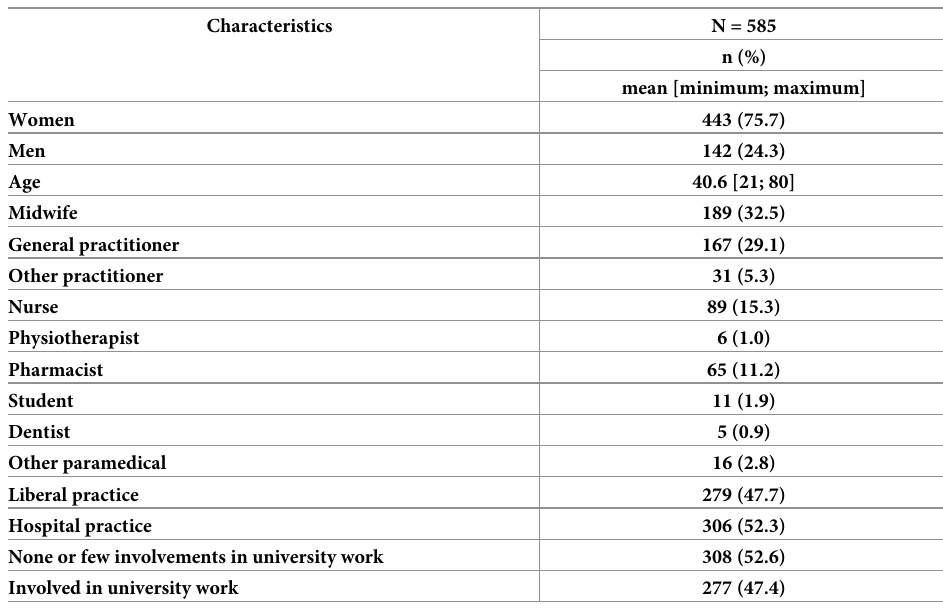
Table 1. Characteristics of population.